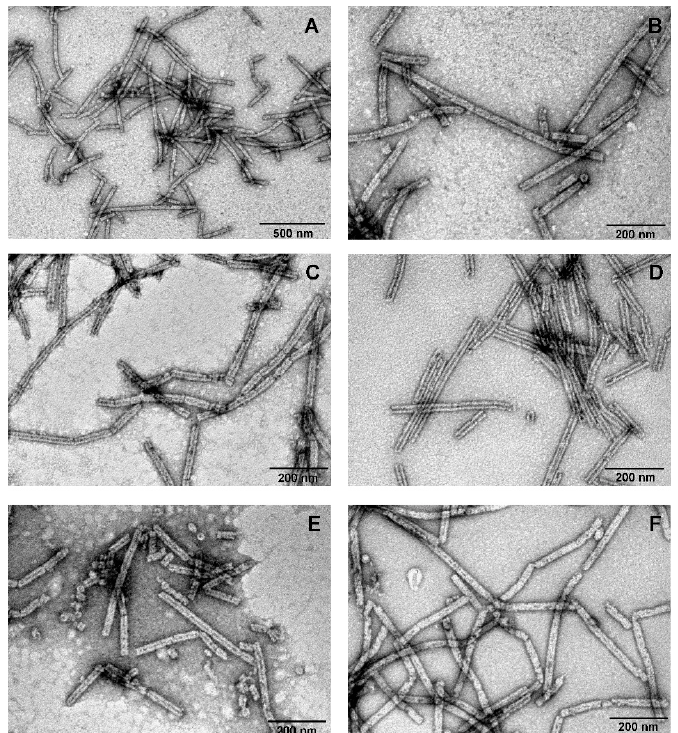
Figure 4. Electron micrographs of the polysheaths formed by wild-type recombinant gp053 from phage FV3. The samples of the purified polysheaths were analysed immediately after purification ( A , B ), following storage in TE buffer at 4 ◦ C for 12 months ( C ), after treatment with trypsin (0.02 mg/mL) at 22 ◦ C for 16 h ( D ), after incubation in the presence of 8 M urea at 22 ◦ C for 16 h ( E ), and after incubation in boiling water for 30 min ( F